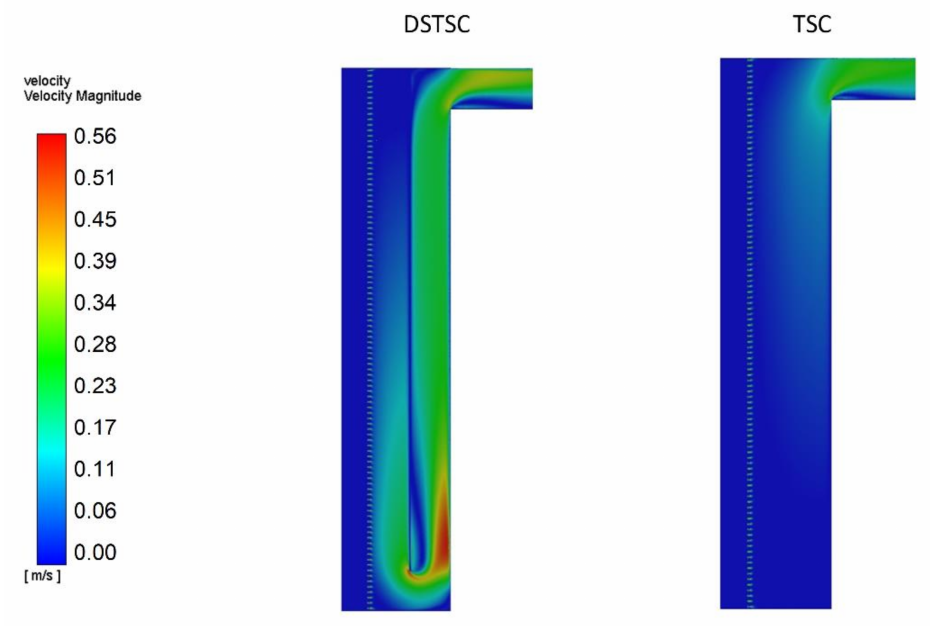
Figure 9. Velocity distribution in a median plane for the DSTSC ( left ) and TSC ( right ) at an air flow of 100 m 3 /h.